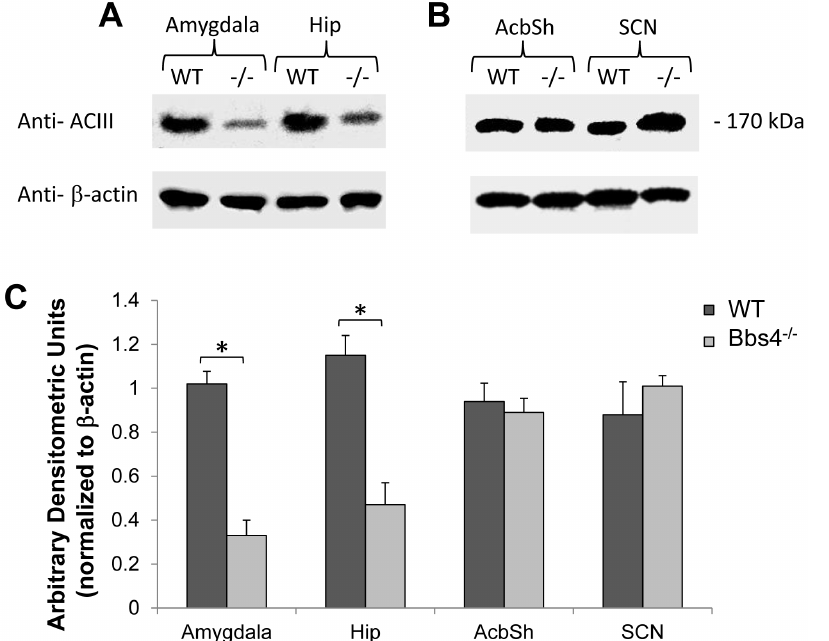
Figure 9. Western blot analysis of ACIII expression in hippocampus, amygdala, AcbSh and SCN of WT and Bbs4 -/- mice brains expression in AcbSh and SCN (B). Shown is a representative western blot from three separate experiments. The data for western blot was collected dissected areas of WT mice brains (dark gray) versus the corresponding dissected areas of Bbs4 -/- mice brains (light gray) using densitometric